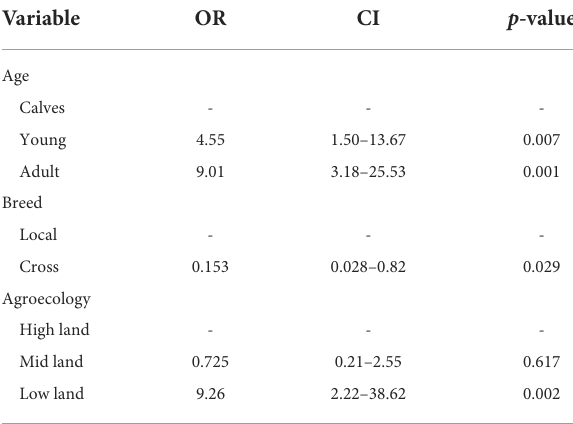
TABLE 4 Multivariable logistic regression results of risk factor